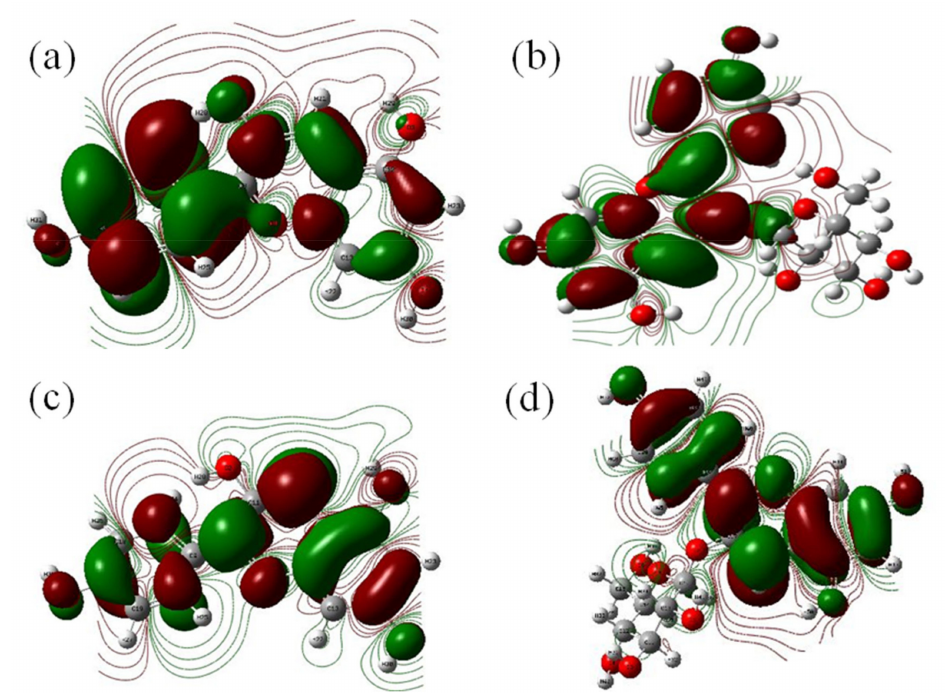
Figure 2. Lowest unoccupied molecular orbitals (LUMO) and highest occupied molecular orbitals (HOMO) derived from frontier molecular orbitals (FMO) analysis: ( a ) LUMO of pelargonidin; ( b ) LUMO of pelargonidin-3-O-glucoside; ( c ) HOMO of pelargonid; and ( d ) HUMO of pelargonidin- 3-O-glucoside.